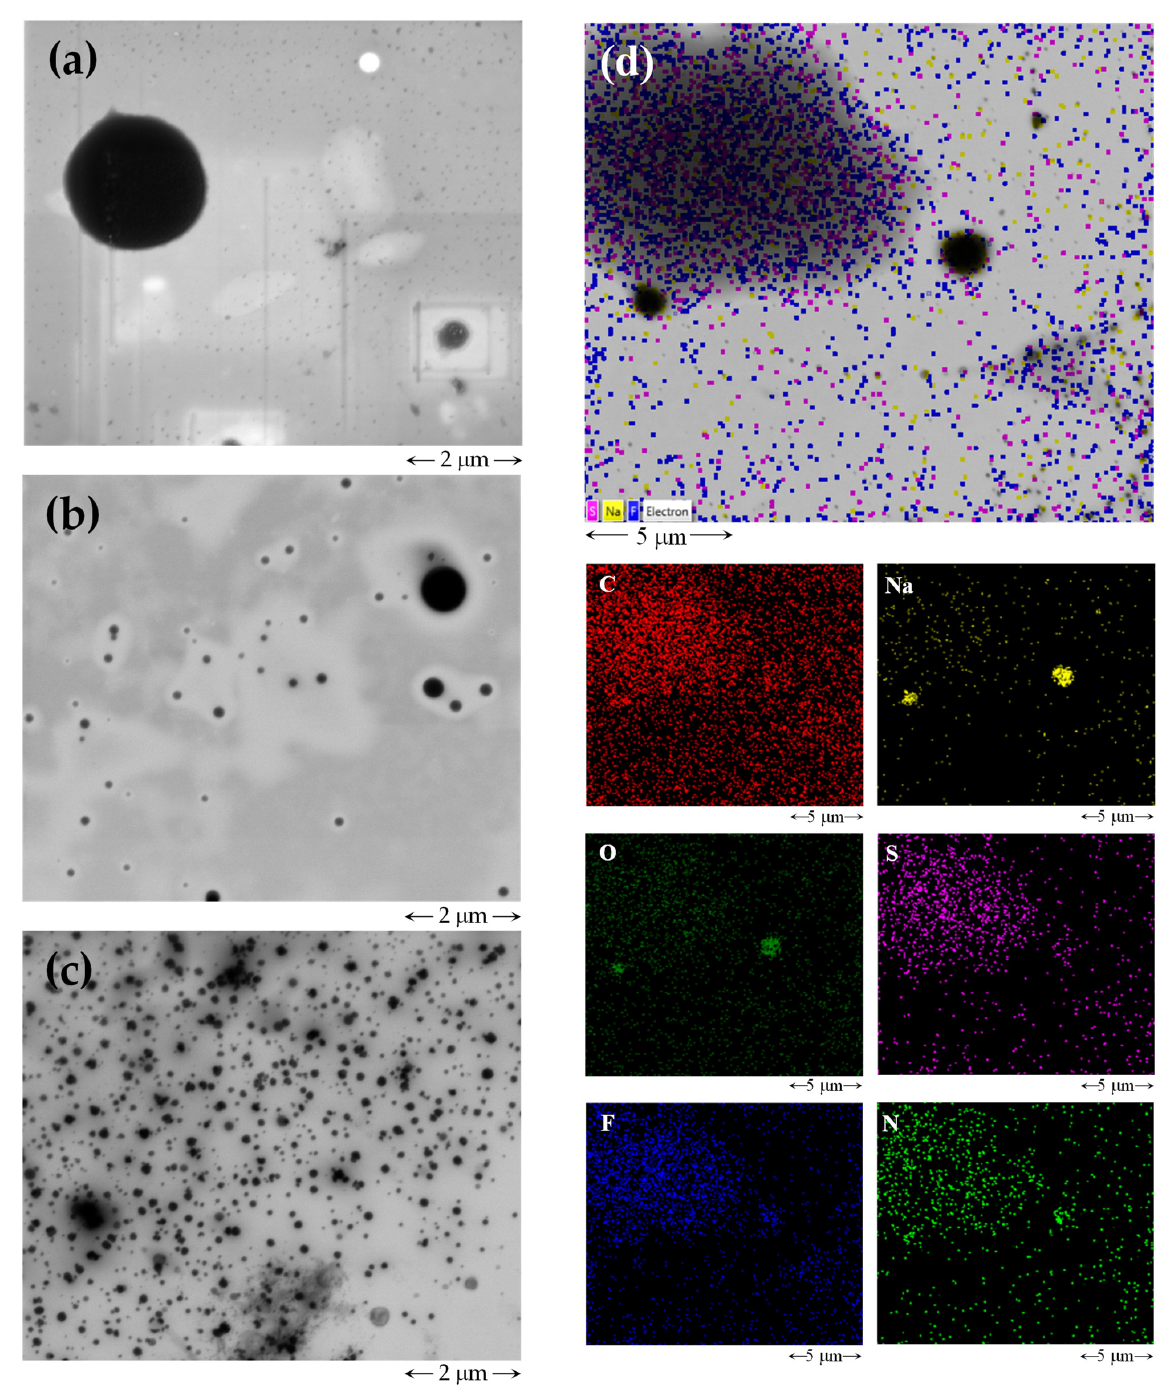
Figure 3. TEM images of ( a ) IFN- α 2b at 0.0001 μ g/mL; ( b ) [C 2 C 1 Im][C 4 F 9 SO 3 ] at 29.2 mM; and ( c ) [C 2 C 1 Im][C 4 F 9 SO 3 ] at 29.2 mM in the presence of IFN- α 2b at 0.0001 μ g/mL. ( d ) EDS analysis of [C 2 C 1 Im][C 4 F 9 SO 3 ] with IFN- α 2b at the same conditions. All samples were prepared in 150 mM NaH 2 PO 4 (pH = 7.4) and measured at 25 °C.